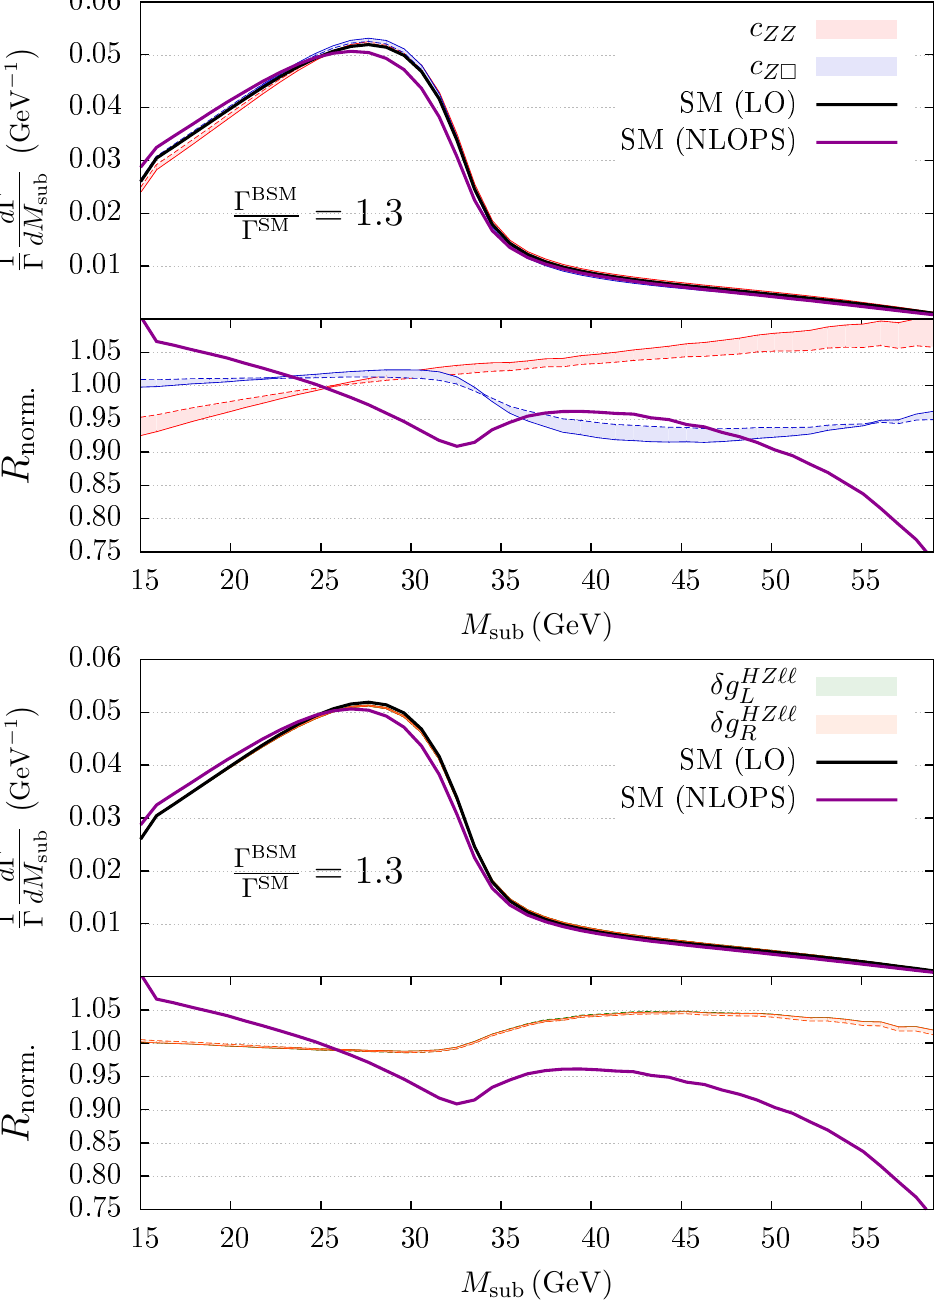
Figure 2. Upper panels: normalized distributions for M sub at LO (black curve), at NLOPS EW accuracy (violet curve) and for values of c ZZ (red curves), c Z (cid:3) (blue curves), (cid:14)g HZ‘‘ giving rise to a ratio R BSM = 1.3. Lower panels: normalized ratios, according to the de(cid:12)nitions in eq. (4.2). Solid lines refer to pure 1 = (cid:3) 2 e(cid:11)ects, for dashed lines quadratic contributions are also included. The shaded bands between solid and dashed lines highlight the shape variations induced by the inclusion of quadratic